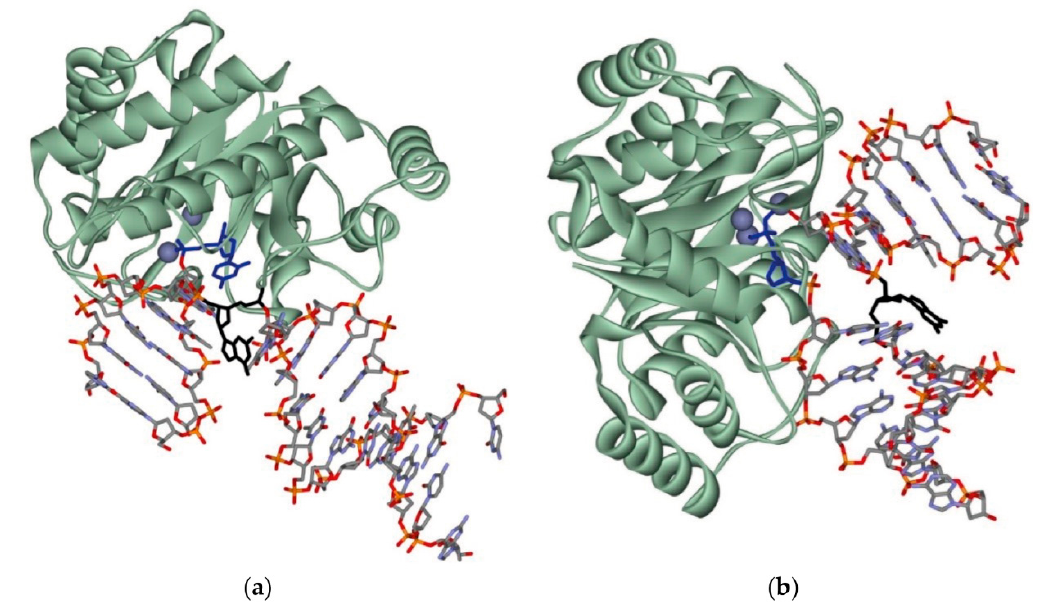
Figure 1. The crystal structure of the exonuclease complex of Nfo with an NIR-mediated DNA (Protein Data Bank [PDB] ID 4K1G) ( a ) and the structure of a complex of Nfo with a DNA substrate containing an F ‐ site (PDB ID 1QUM) ( b ).